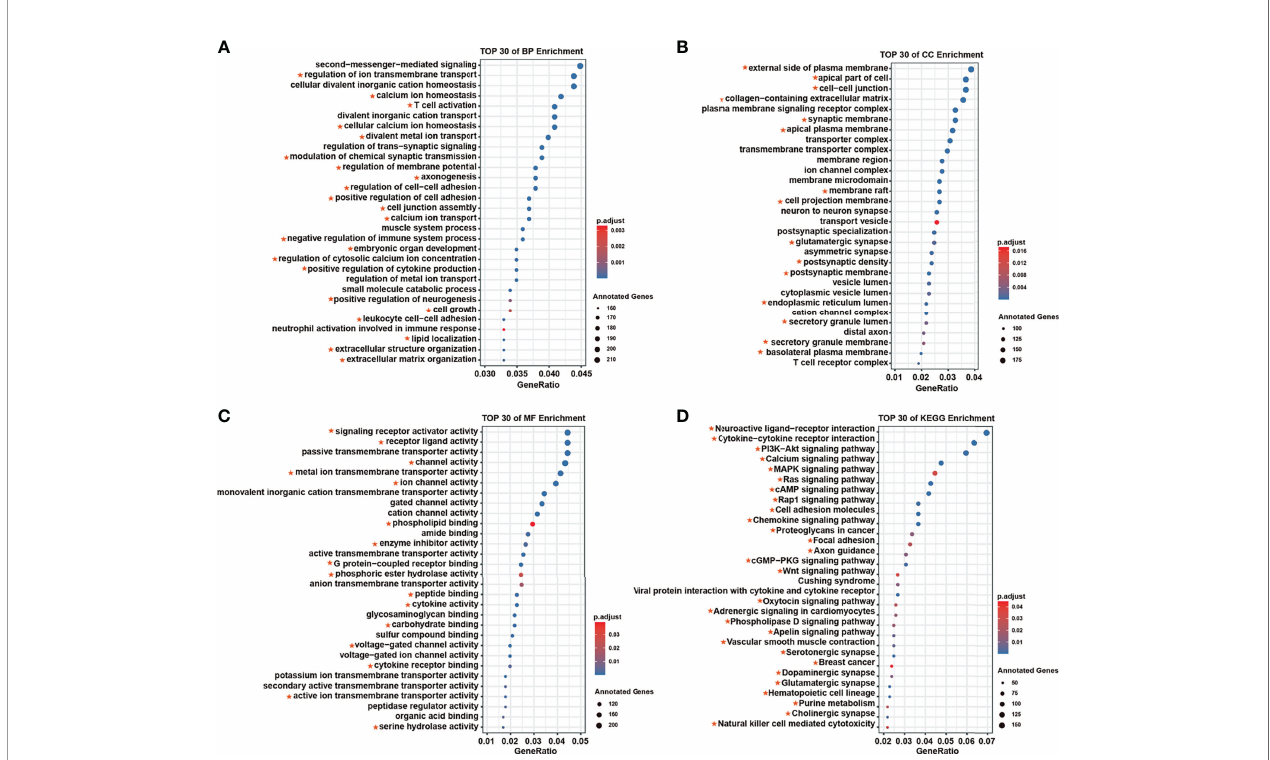
FIGURE 2 | The top 30 annotations for survival-related modules. (A) Biological process enrichment. (B) Molecular function enrichment. (C) Cellular component enrichment. (D) Kyoto Encyclopedia of Genes and Genomes enrichment. The red star represents the con fi rmed function associated with breast cancer in the Comparative Toxicogenomics